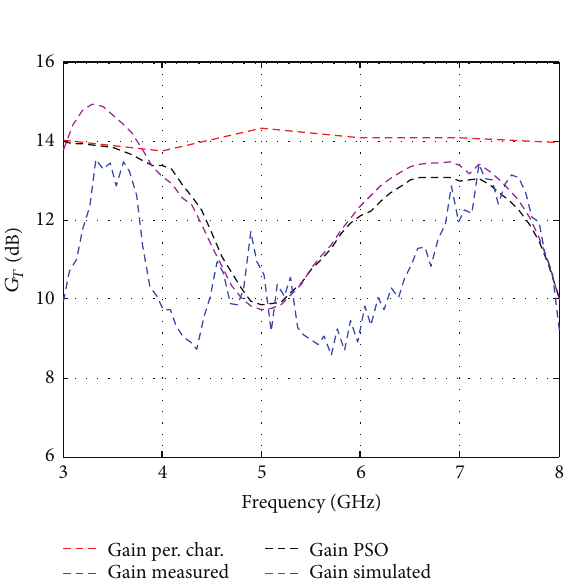
Figure 10: Comparative results for transducer gain of designed amplifier.